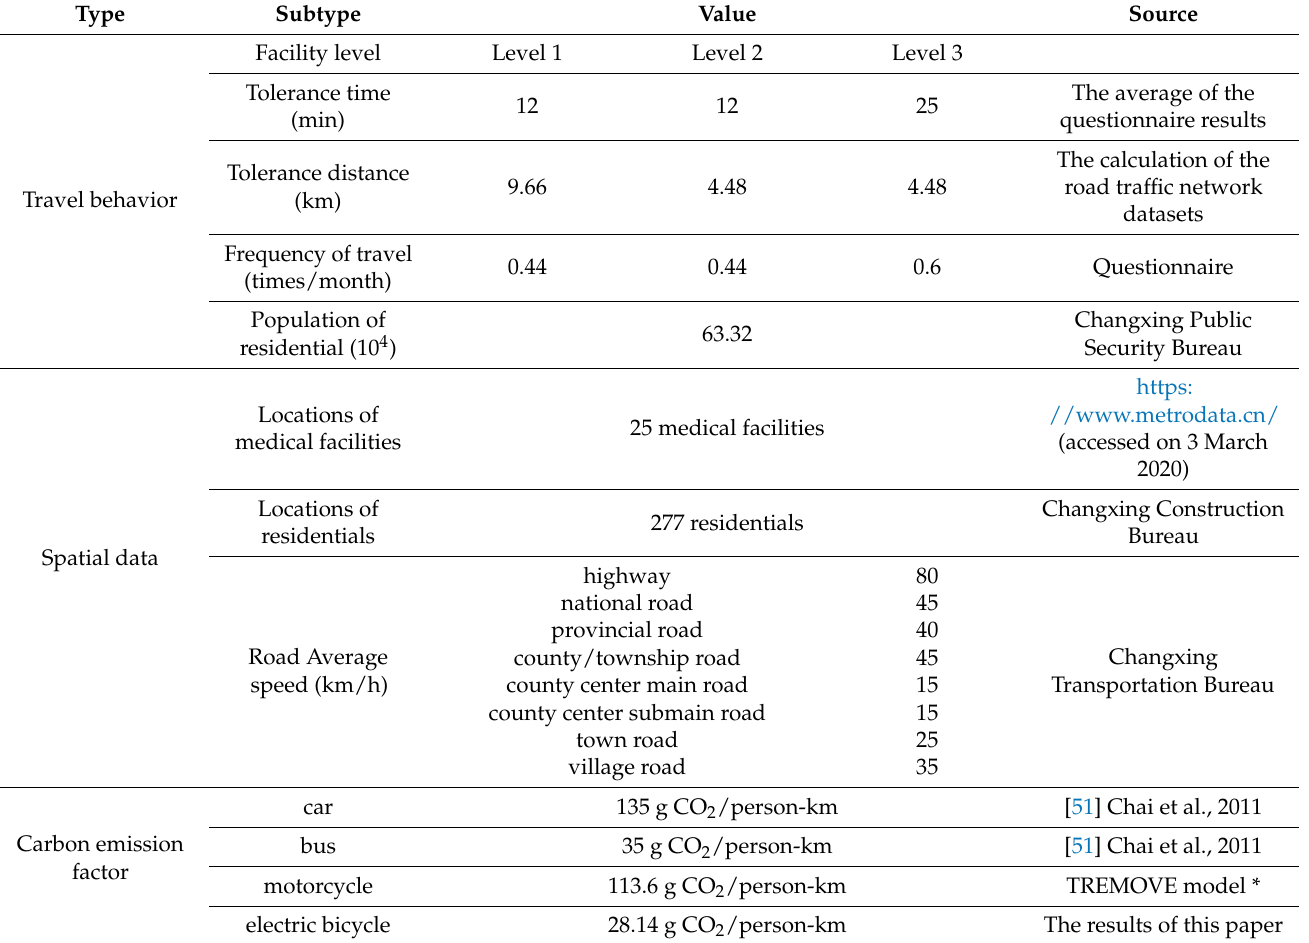
Table 2. Datasets used in the